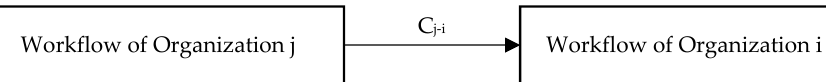
Figure 4. Correlation of interorganizational workflow.